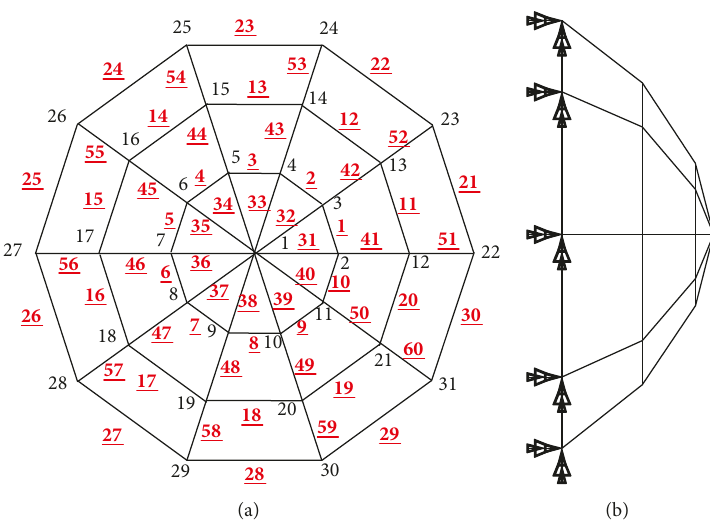
Figure 6: Number of joints and components in dome.